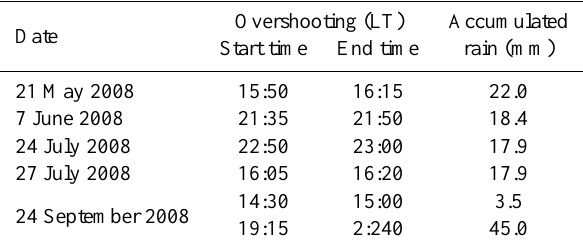
Table 2. The timings (start and end time) of overshooting in each convection event. The accumulated rainfall during the total event (not only during overshooting period) is also included in the